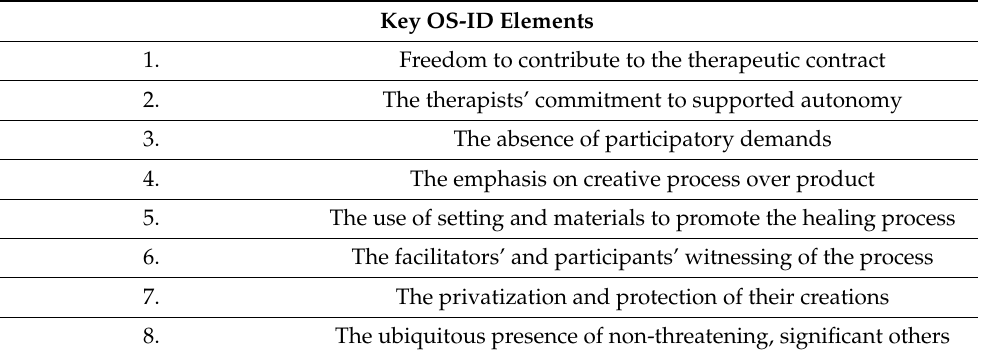
Table 5. Eight key elements in Ethan’s and Liora’s OS-ID healing